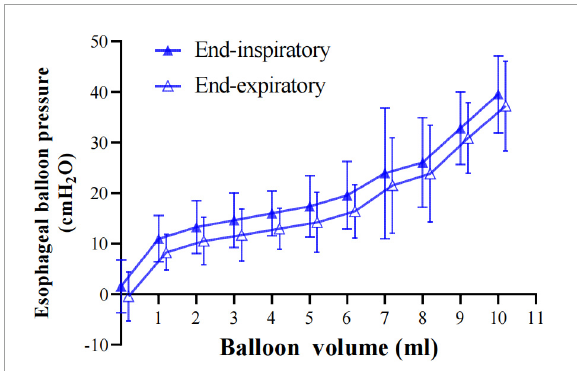
FIGURE1 Esophageal balloon pressure-volume curves. Relationship between balloon filling volume and Pes values, both at end-inspiration (PesEI, solid blue triangle) and at end-expiration (PesEE, hollow blue triangle). On the end-expiratory pressure-volume (P-V) curve, the intermediate linear section was graphically detected and analyzed for its lower and upper limits (V MIN and V MAX , respectively). The range between V MIN and V MAX was considered to correspond to appropriate balloon filling, with volumes below V MIN denoting underfilling and volumes above V MAX denoting overdistention. Within the appropriate filling range, we identified V BEST , i.e., the filling volume associated with the maximum difference between PesEI and PesEE. Pes: esophageal pressure. Data are shown as mean value ± standard